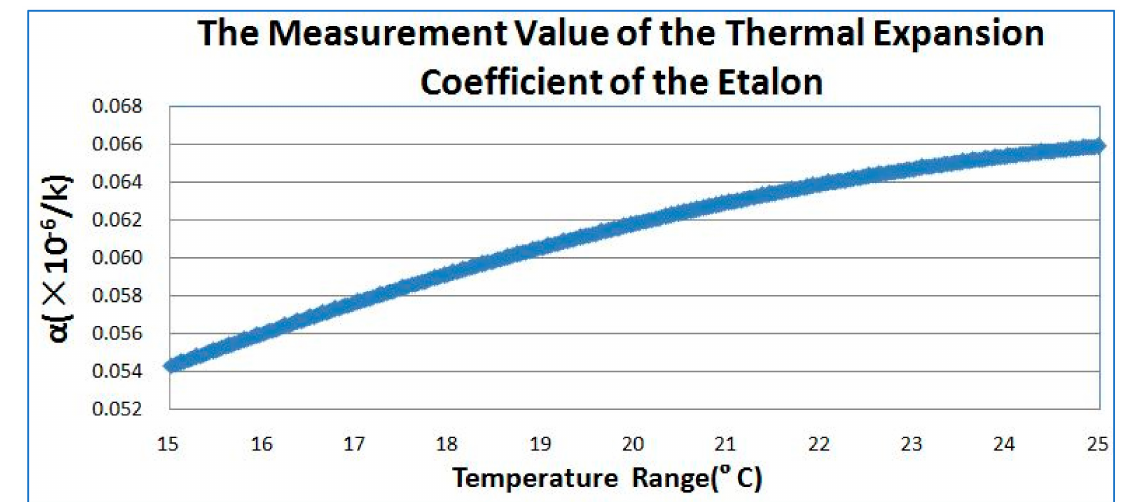
Figure 4. The measurement value of the thermal expansion coefficient of the